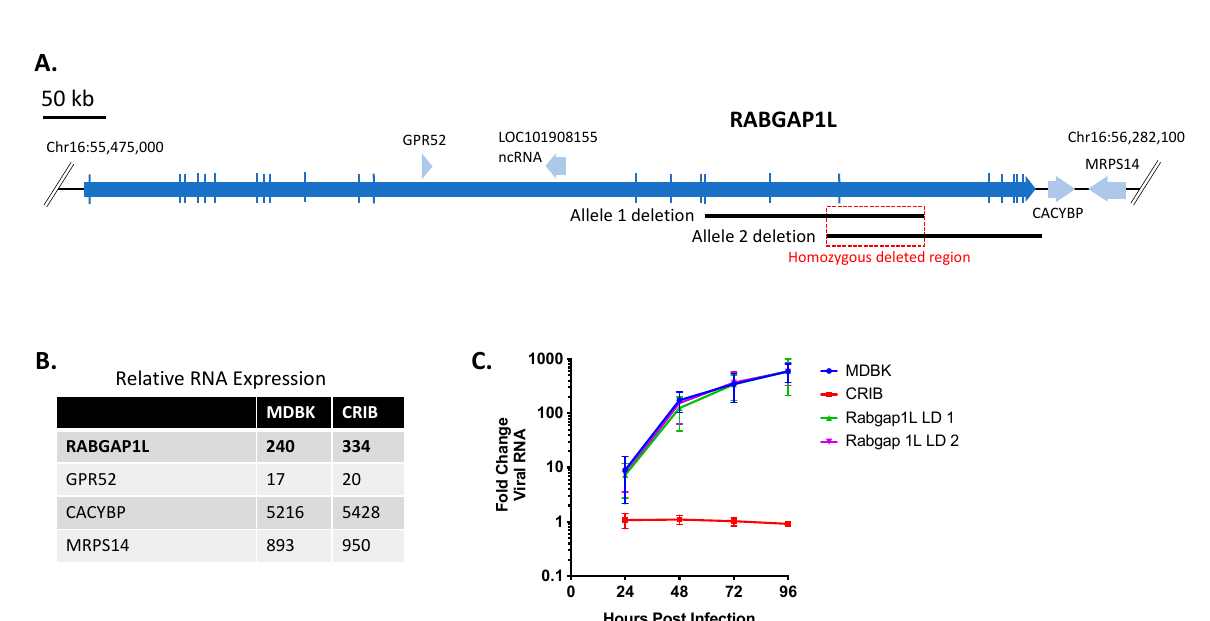
Figure 4. Disruption of the RABGAP1L gene does not significantly impact BVDV infection in MDBK cells. Panel ( A ), map of bovine RABGAP1L and surrounding genes: blue arrows, genes (open reading frames); black lines, heterozygous deletions in two alleles of RABGAP1L on chromosome 16; light red deletion block, homozygous deleted region (69,384 bp); red block, CRISPR/Cas9-mediated homozygous deletion. Shown is the corrected annotation for RABGAP1L based on IsoSeq data (see methods and Figure 1C). Panel ( B ), Relative RNA expression levels in MDBK and CRIB cells (TMM normalization value). Panel ( C ), Multistep virus growth curve. Cells were infected with BVDV strain NADL (MOI 0.01). Cells were collected and processed 0–96 h post-infection for quantitation of viral RNA using RT-qPCR. Results represent the mean ± standard deviation ( n = 3).